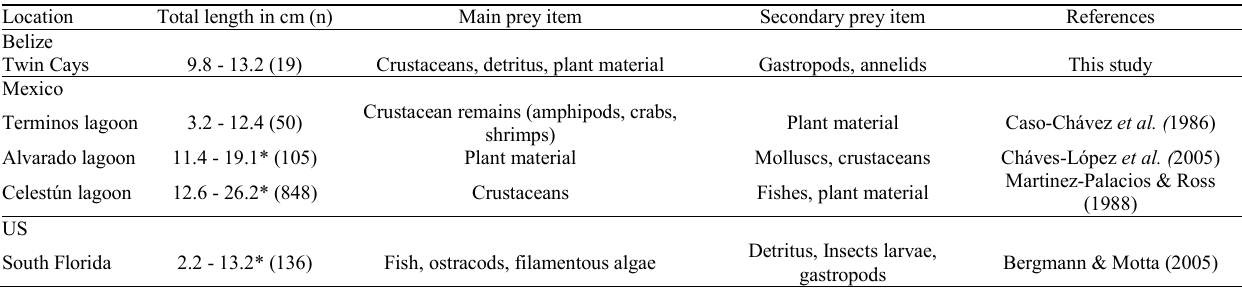
Table 2. Review of gut-content analyses performed on Cichlasoma urophthalmus specimens from the Caribbean and Florida. n, number of fish specimens studied for gut-content analyses. * Obtained with the relationships standard length-total length from FishBase (Froese & Pauly,